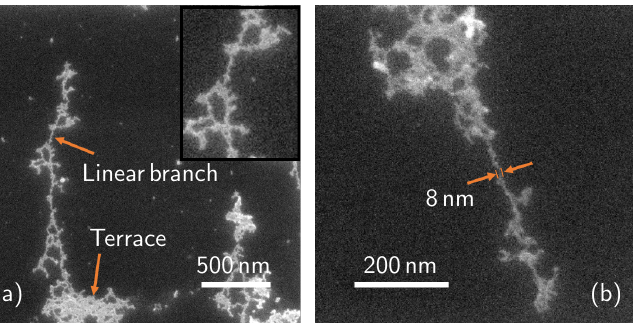
Figure 4. SEM plan images of the samples dip-coated in a 10% concentrated DPP solution for 15 min and cleaned after the deposition step. ( a ) Molecular branch and terrace, the inset shows a detail of the linear branch. ( b ) A thin, developed